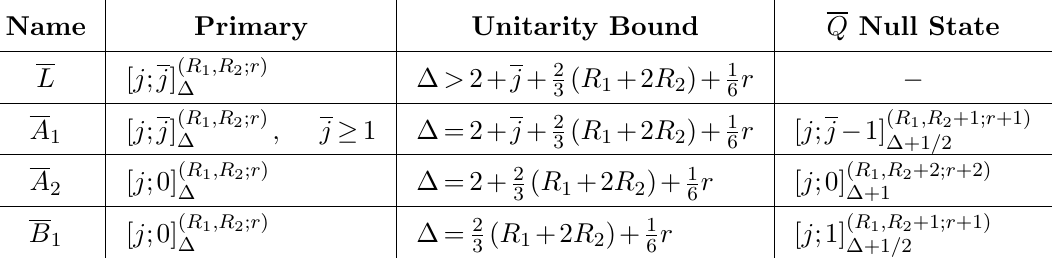
Table 17 . Q shortening conditions in four-dimensional N = 3